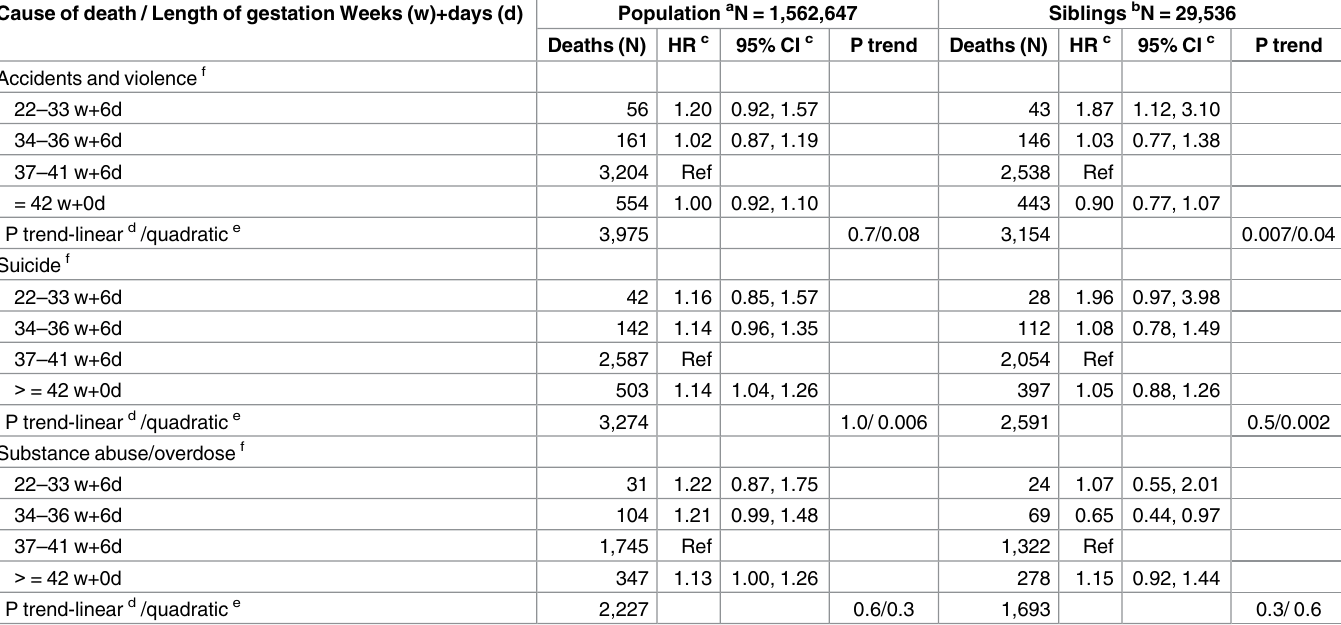
Table 3. Mortality and gestational age by external cause of death. Nation-wide cohort born in Norway 1967–1997. Cause of death / Length of gestation Weeks (w)+days